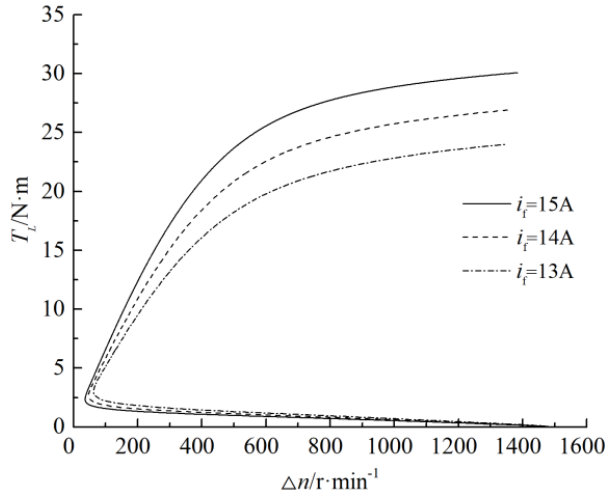
Figure 7. Curves of the speed difference-load torque relationships.